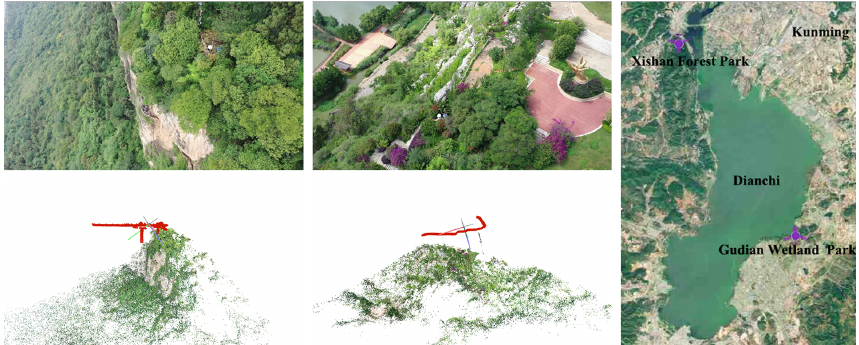
Figure 4. Data set collection and experimental scenes. The scene on the left is Xishan Forest Park (24 ◦ 57 (cid:48) 6 (cid:48)(cid:48) N 102 ◦ 38 (cid:48) 24 (cid:48)(cid:48) E) and on the right is Gudian Wetland Park (24 ◦ 46 (cid:48) 34 (cid:48)(cid:48) N 102 ◦ 44 (cid:48) 57 (cid:48)(cid:48)